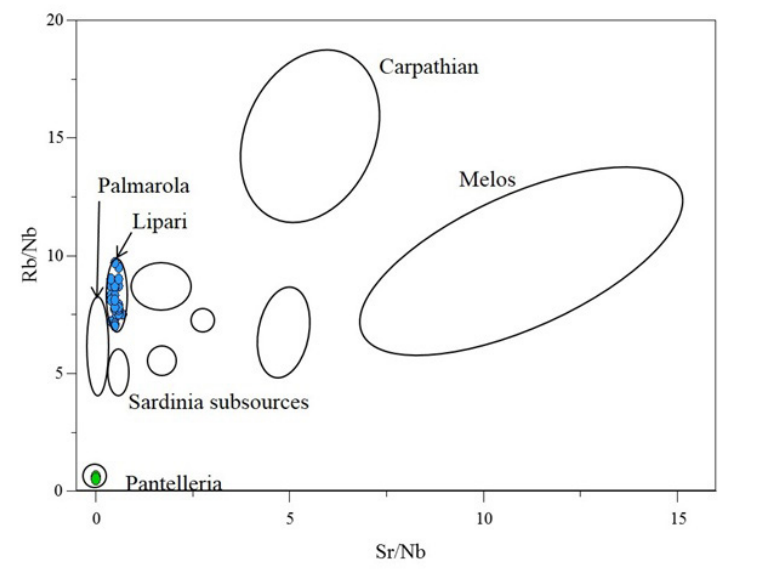
Figure 9 . Graph of Rb, Sr, and Nb ratios showing assignment of the Spalmatore obsidian artifacts to ellipses based on many geological samples analyzed with the same pXRF.